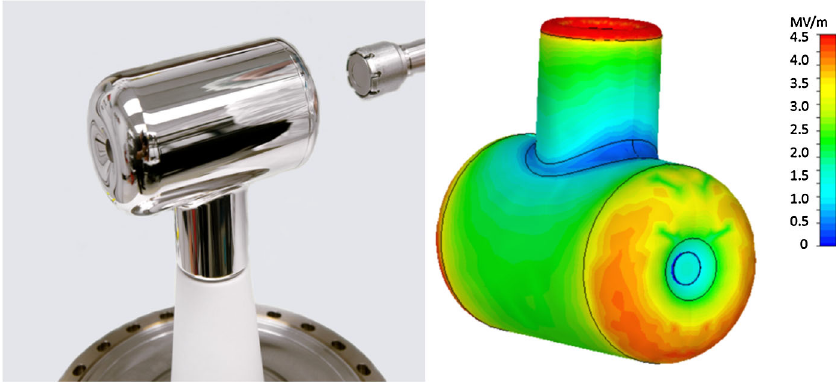
FIG. 2. (Color) Electrostatic field gradient map of the electrode inside the CEBAF inverted gun. The maximum field gradient within the cathode/anode gap is 4 : 5 MV = m . The gradient at the joint between the insulator and electrode is higher, (cid:1) 7 MV = m , but does not appear to be problematic. The photograph shows the actual electrode attached to the insulator and 10 00 CF flange, with photocathode puck being installed from